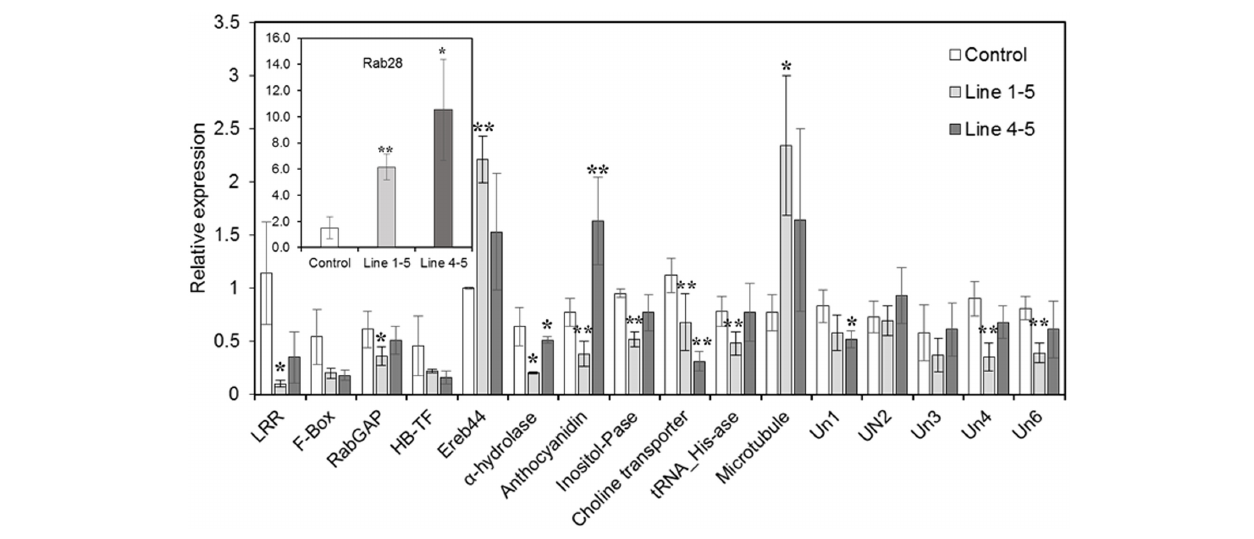
FIGURE 6 | Relative expression of predicted ZmPRms -regulated downstream target (obtained from gene regulatory network analysis; Figure 5 and Table 1 ) candidate genes in the control (empty vector transformed) and ZmPRms– RNAi transgenic maize kernels at 7 days post inoculation (dpi) with A. flavus . Gene expression was normalized to the maize ribosomal structural gene GRMZM2G024838 (Shu et al., 2015). Data are mean ± SE of 3–4 biological replicates. ∗∗ / ∗ Denote significant difference between control and PRms silenced lines ( ∗∗ P ≤ 0.05, ∗ P ≤ 0.1). Un1 (Uncharacterized 1; GRMZM2G042752), Un2 (Uncharacterized 2; GRMZM2G061398), Un3 (Uncharacterized 3; GRMZM2G092415), Un4 (Uncharacterized 4; GRMZM2G101412), Un6 (Uncharacterized 6; GRMZM2G383338).